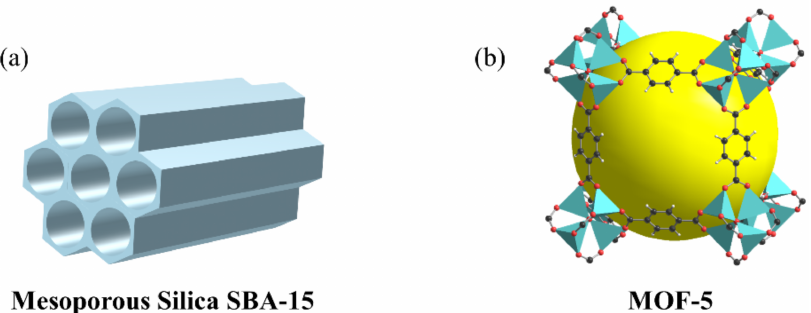
Figure 3. Structural diagram of typical novel carrier material: ( a ) mesoporous silica SBA-15, ( b )